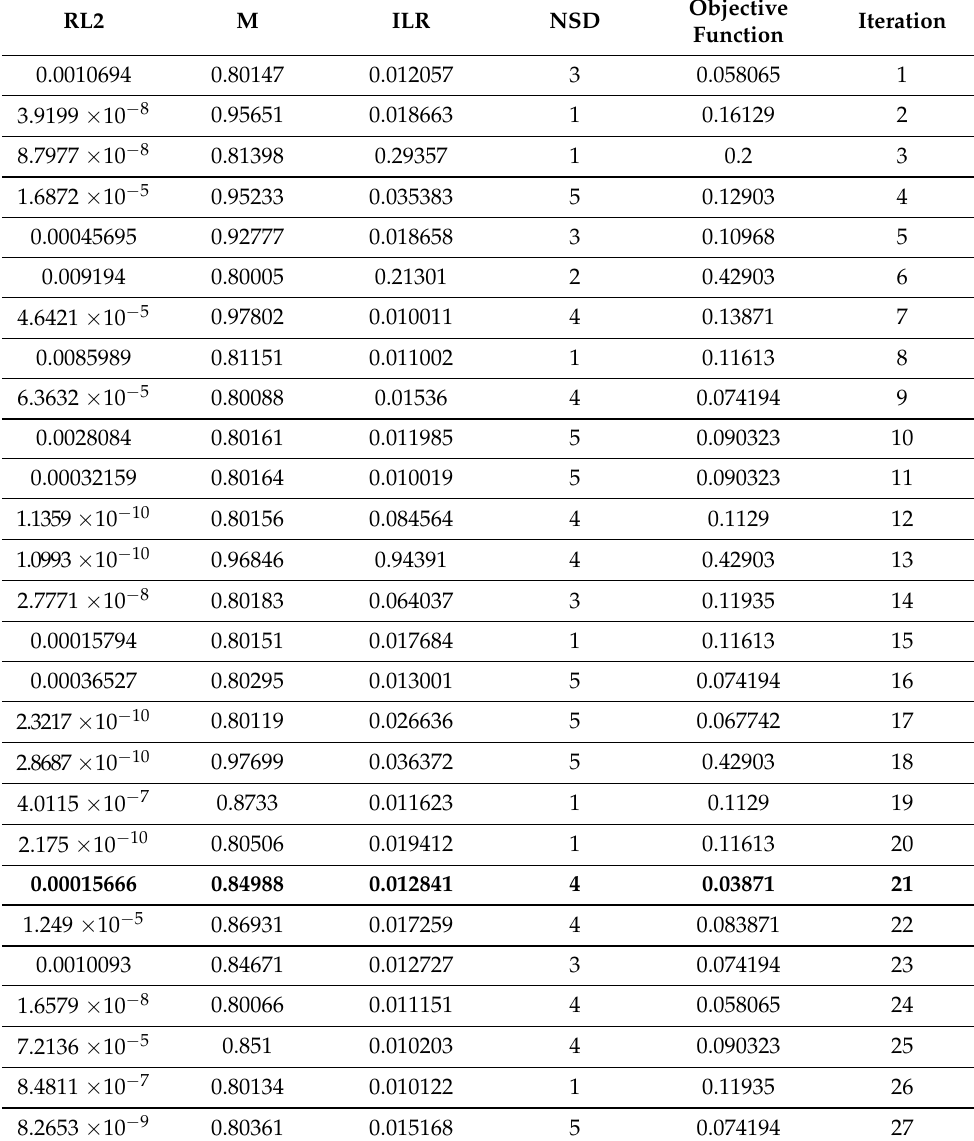
Table 2. Objective function evaluations and corresponding optimization variables estimates of the proposed CNN trained by fundus retinal images in Experiment 1. Entries of the optimal model are highlighted in bold